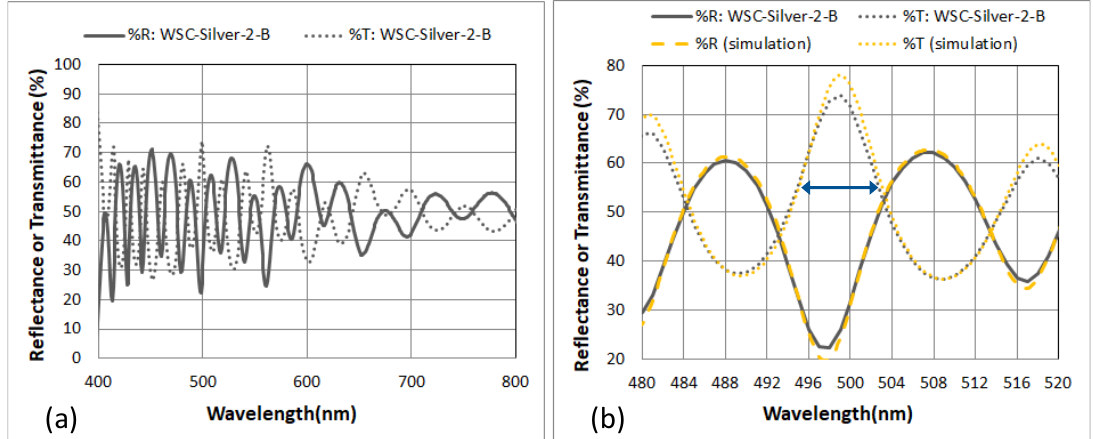
Figure 5. Reflectance and transmittance for wavelength selective hard coating sample ( a ) WSC–Silver–2–B and ( b ) WSC-Silver-2-B, narrowband detail view, made using Design Strategy 2. ( a ) shows multiple high-frequency oscillations in reflectance and transmittance, leading to narrowband features are observed in the WSC–Silver–2–B design. ( b ) shows narrowband optical transmission due to resonant cavity effects in this hard coating design, with the highlighted transmission peak having a FWHM of ~8 nm or ~1.6% of the central wavelength (blue arrow). Experimental results (grey) show good agreement with transfer matrix simulations (gold) for transmittance at 0 degrees and reflectance at 8 degrees. We expect that these designs can be further optimized for narrowband applications while preserving the high hardness coating structure.